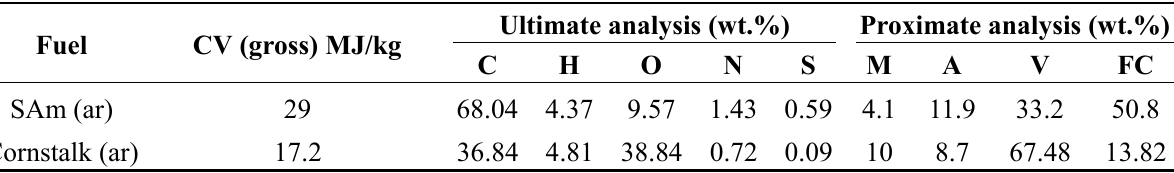
Table 1. South American coal (SAm) and cornstalk fuel analysis. CV: calorific value. Ultimate analysis (wt.%) Proximate analysis (wt.%) Fuel CV (gross) MJ/kg C H O N S M V FC SAm (ar) 29 Cornstalk